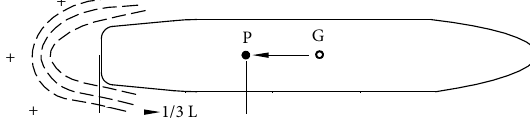
Fig. 12. The location of the pivot point when the ship moves